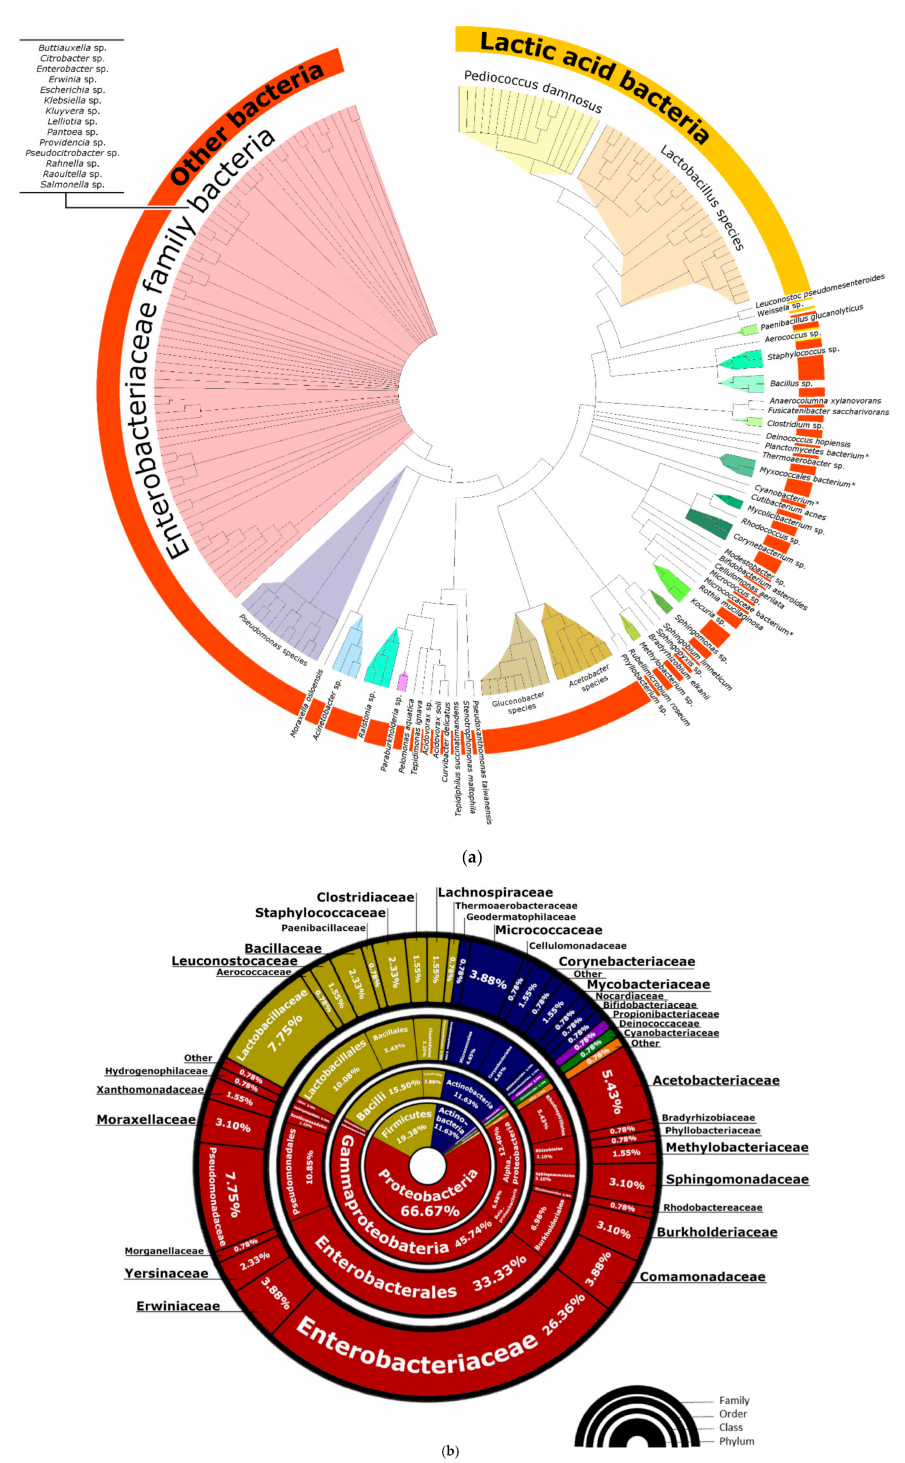
Figure 4. Phylogenetic analysis and abundance of bacterial taxa. ( a ) Phylogenetic tree constructed based on the ASVs of 120 bacterial species found in the mixed-culture samples. Phylogenetic relationships were made using MEGA v.10.1.7 software for alignment, construction, and visualization of the phylogenetic tree. Sequence alignment was performed using ClustalW. Supplementary Information File S2 contains a high-resolution version of Figure 4a, suitable for zooming and enlargement. ( b ) The image shows the prevalence of taxonomic classifications according to the genera and species found in the bacterial microbiomes. Higher taxonomic classifications are shown in circles near the image center, while lower classifications are shown toward the outer edge. Images were constructed using MEGA and GIMP 2.1